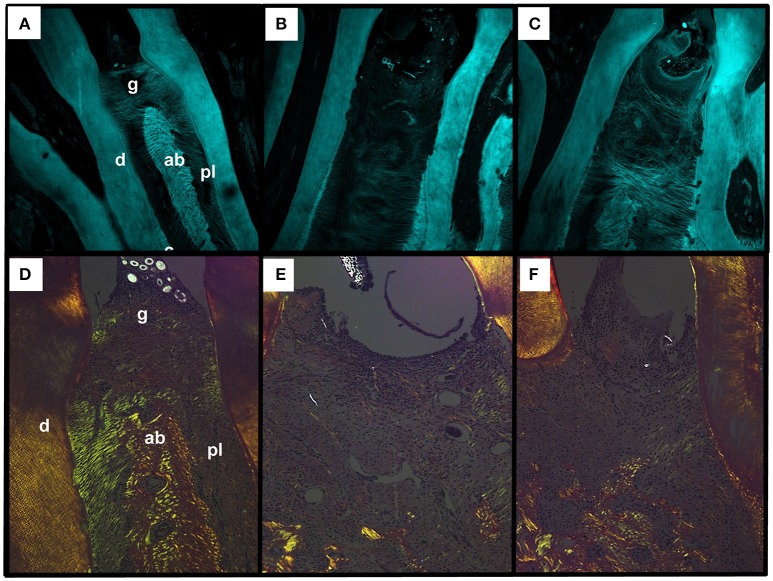
Effect of CLO on collagen fibers of alveolar bone of rats with EP. Naïve (A,D), SAL (B,E), CLO (C,F). Dentin (d); Alveolar bone (ab); Periodontal ligament (pl); Gingiva (g). (Magnification 40x).